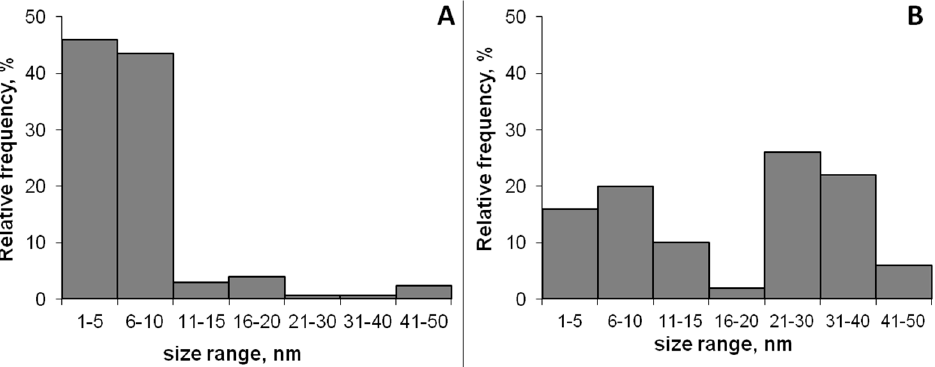
Figure 4. Particle size distribution estimated from TEM micrographs of AgNPs produced by UV treatment ( A ) and by thermal treatment ( B ). N =100.